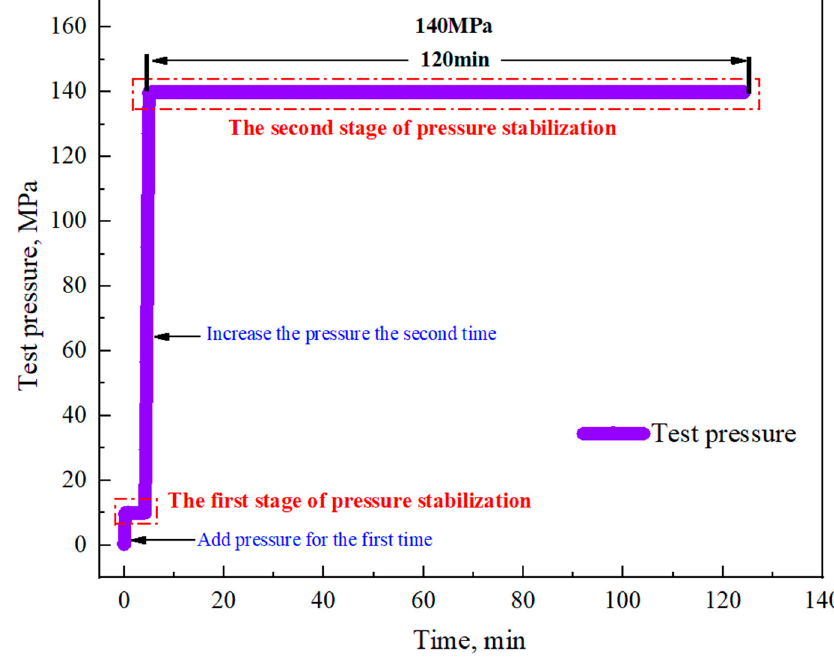
Figure 15. Test pressure vs. time.